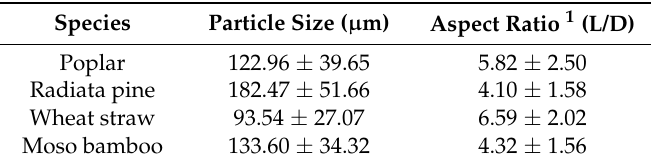
Table 2. Particle sizes and shapes after